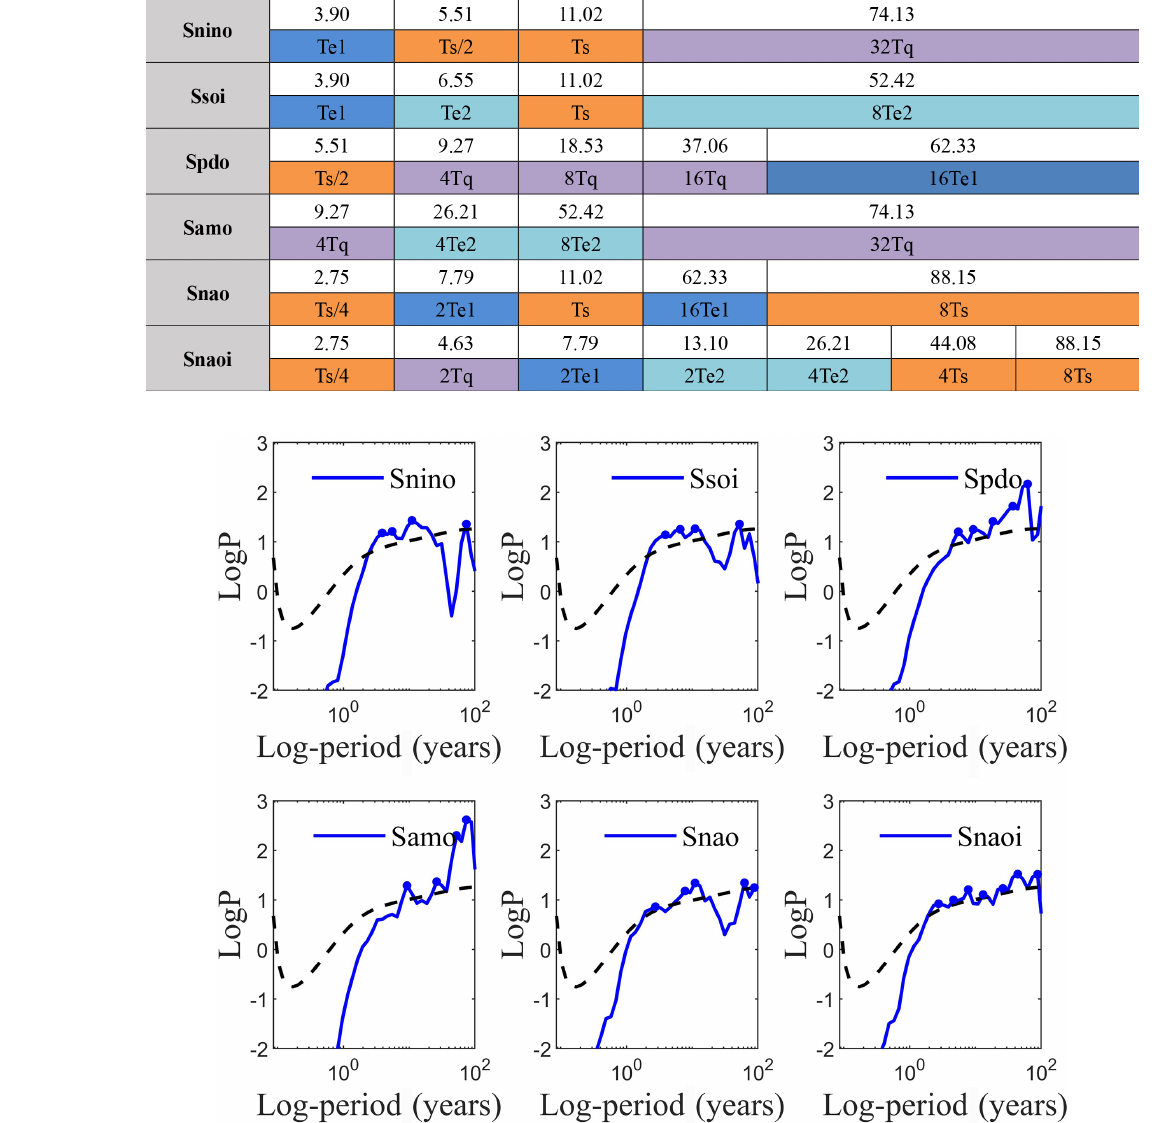
Figure 2. The time-averaged power spectrum of SFA-extracted ( m = 11) slow feature signals for six climate indices; the significant points (blue dots) with peak power that pass the significance test at the 0.05 significance level (black dashed lines) are also indicated.